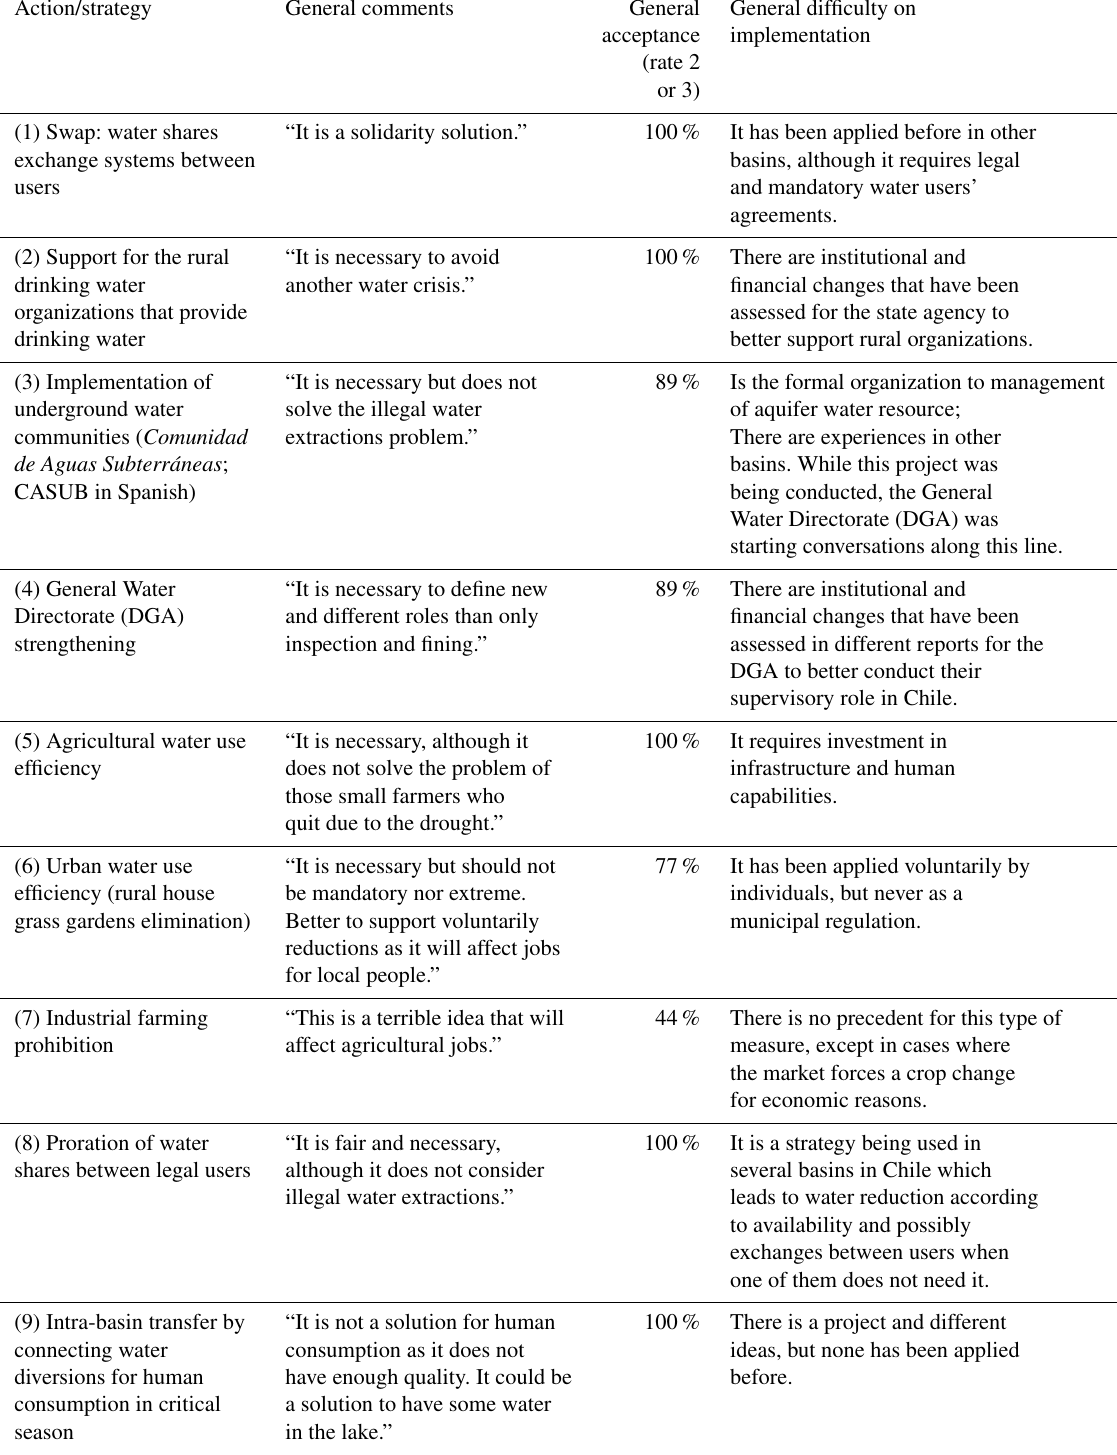
Table 2. Assessment and general comments on the strategies or lines of actions provided by the